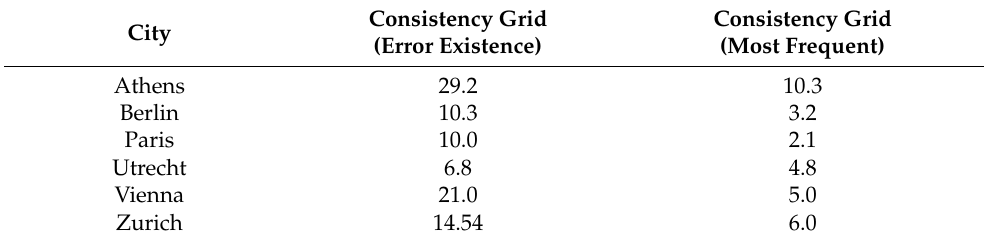
Table 8. Global topo-semantic error percentages. City